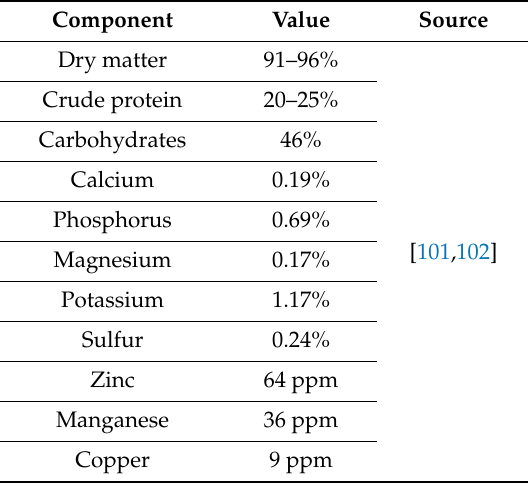
Table 5. Chemical composition of germ / rootlets after